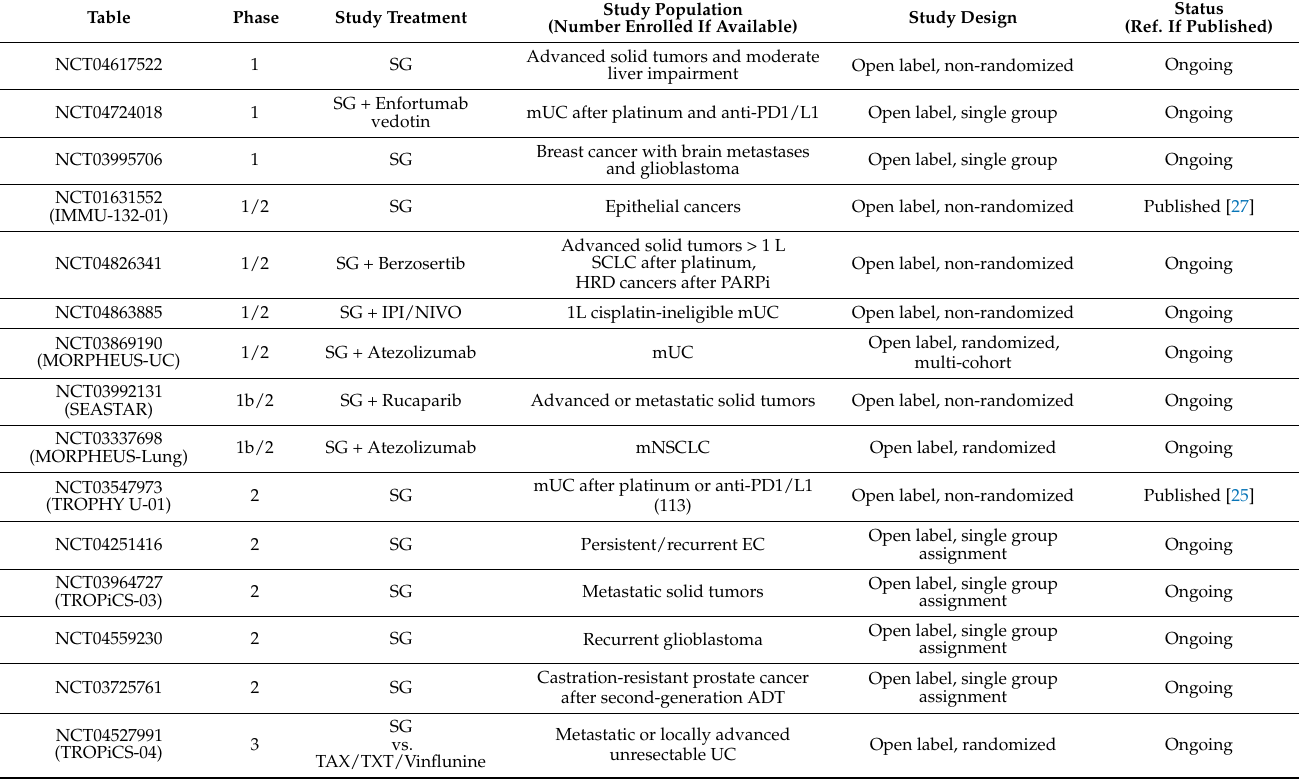
Table 2. Selected published and ongoing trials testing Sacituzumab govitecan in solid tumors other than breast cancer. Table